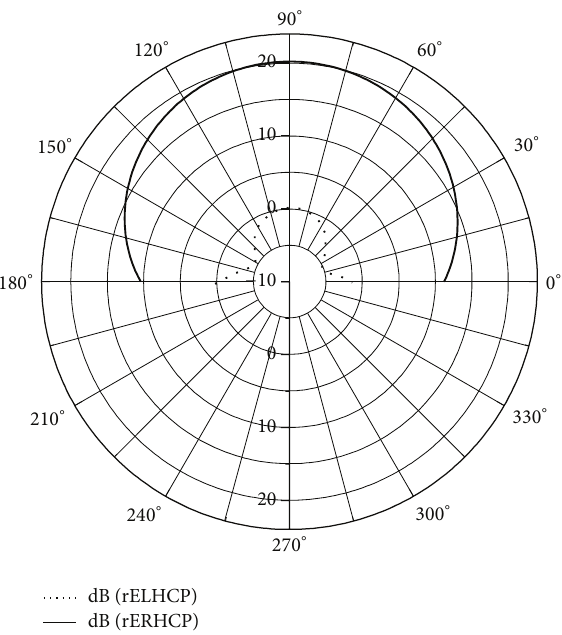
Figure 6: Isolated element pattern of the circularly polarized microstrip